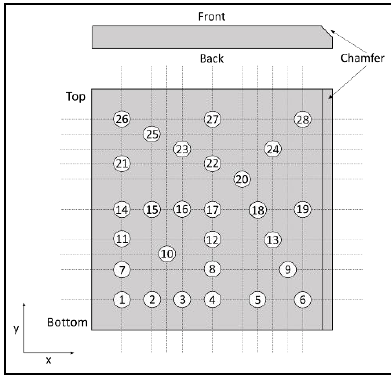
Figure 3: NPL holeplate schematic indicating position of